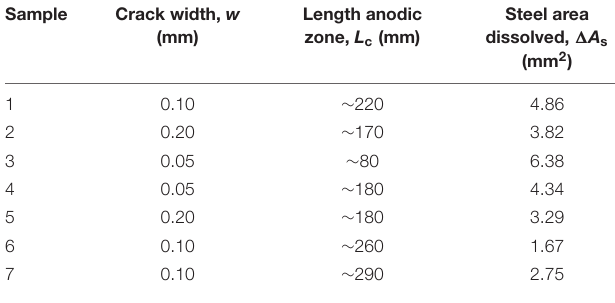
TABLE 3 | Experimental crack width values due to corrosion, calculated using data from the literature (Poupard et al., 2006).